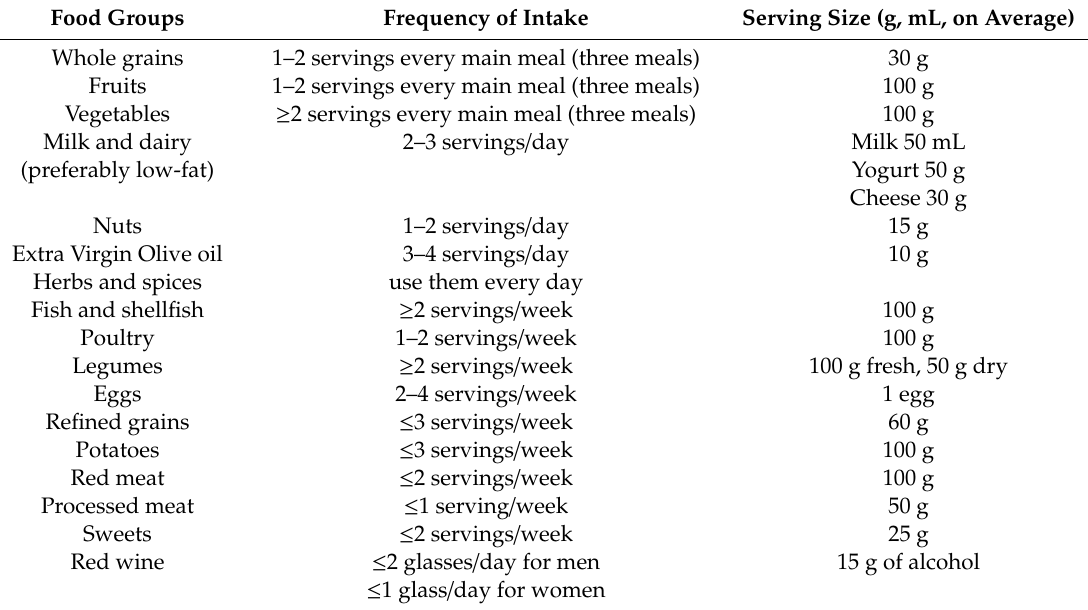
Table 17. Mediterranean Diet Pyramid proposed for Italian people (MDPPI).